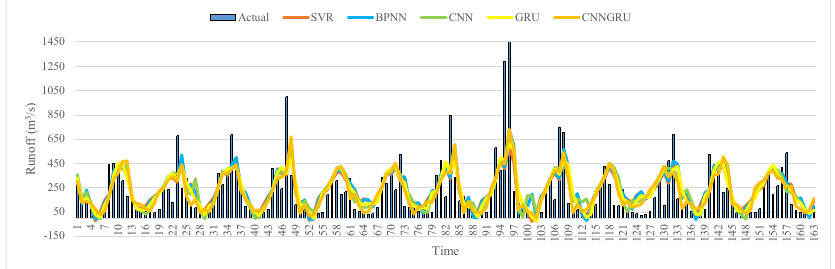
Figure 7. Forecasting curves estimated by all the single models.